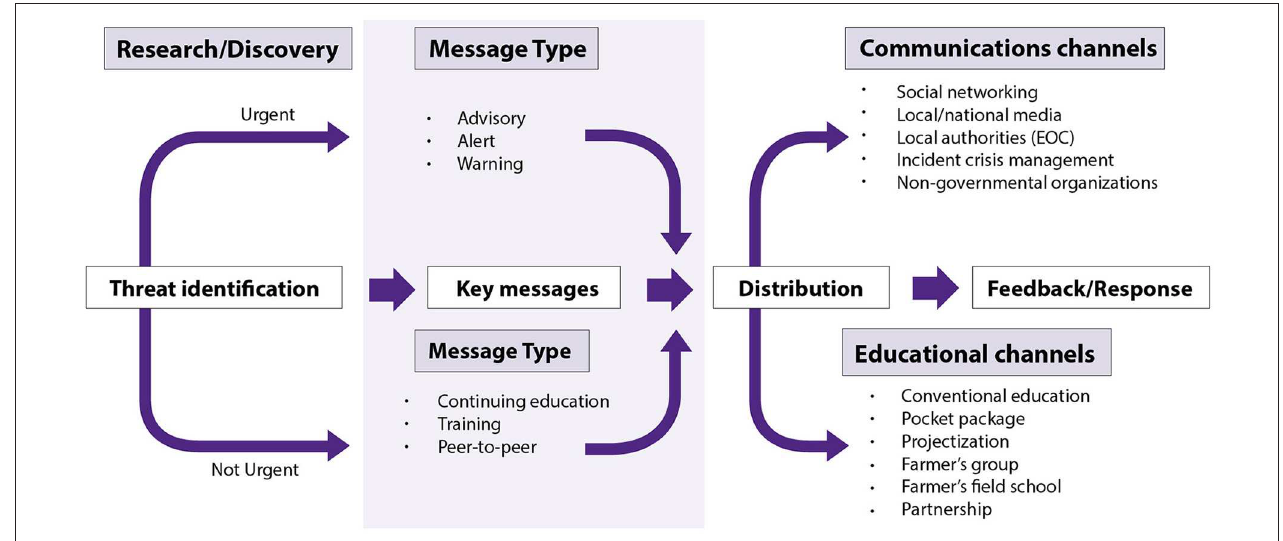
FIGURE 3 | Time-sensitive and time-agnostic paths for communicating about food safety (or other) threats from scientists to the general